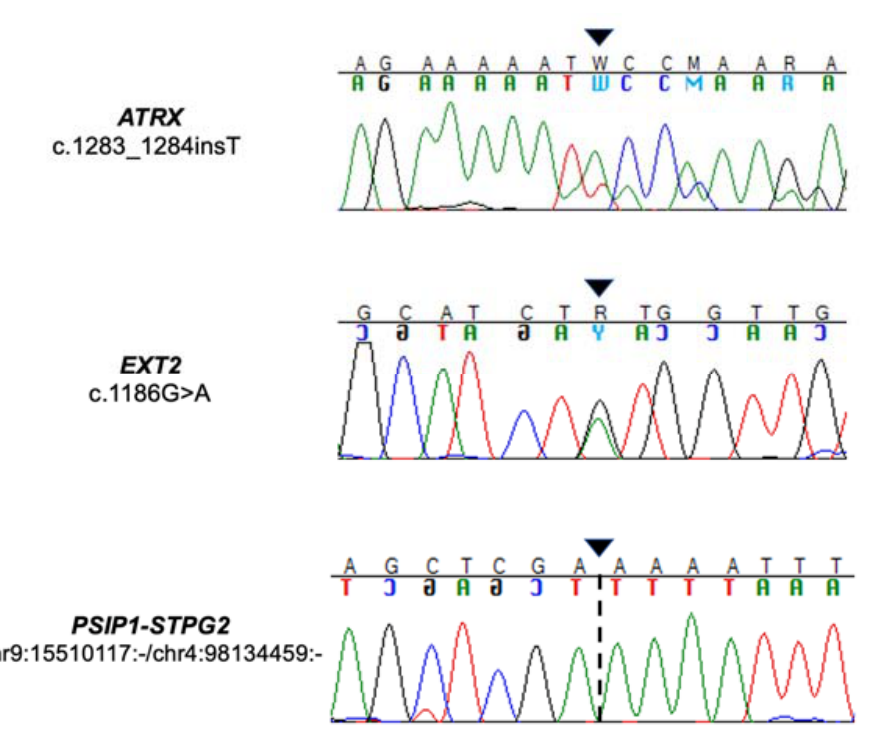
Figure 6. Chromatograms from Sanger sequencing analysis showing the following events (black arrows): in the osteosarcoma case, frameshift alteration in the ATRX gene due to the insertion of a thymine, and in the leiomyosarcoma case, missense mutation caused by the substitution of an adenine with a guanine in the EXT2 gene and PSIP1-STPG2 gene fusion, respectively. Lastly, the c.1461+2T>G variant affecting the COL1A1 gene seems to cause loss of the donor splice site at intron 21-22 on chr17:50194719. According to ClinVar, this alteration is likely pathogenic (Table